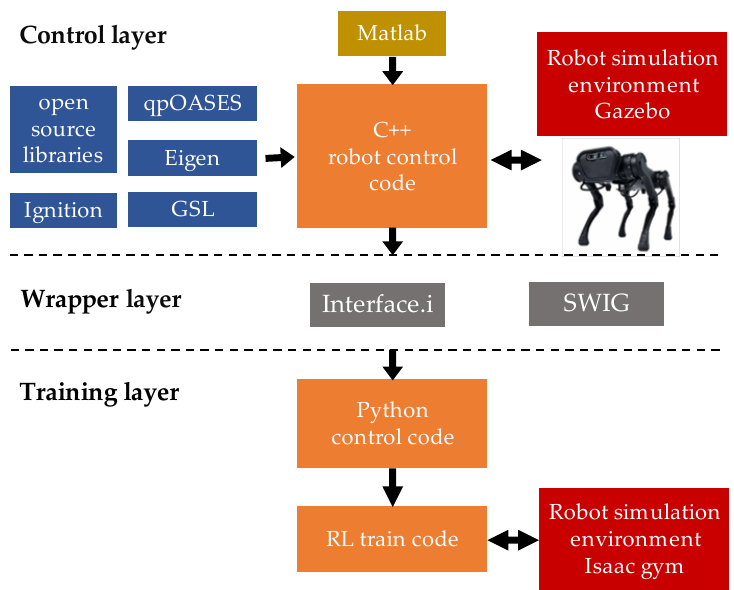
Figure 6. The software architecture of quadruped robot control.